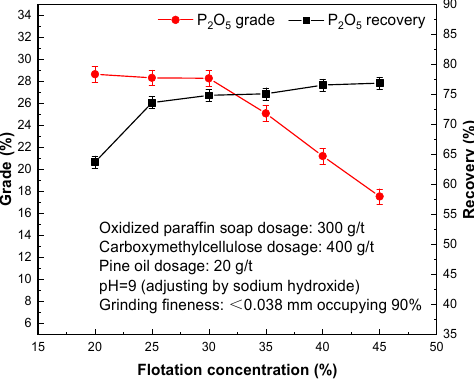
Figure 8. E ff ect of flotation concentration on extracting phosphorous. Figure 8. Effect of flotation concentration on extracting phosphorous. Figure 8. Effect of flotation concentration on extracting phosphorous.